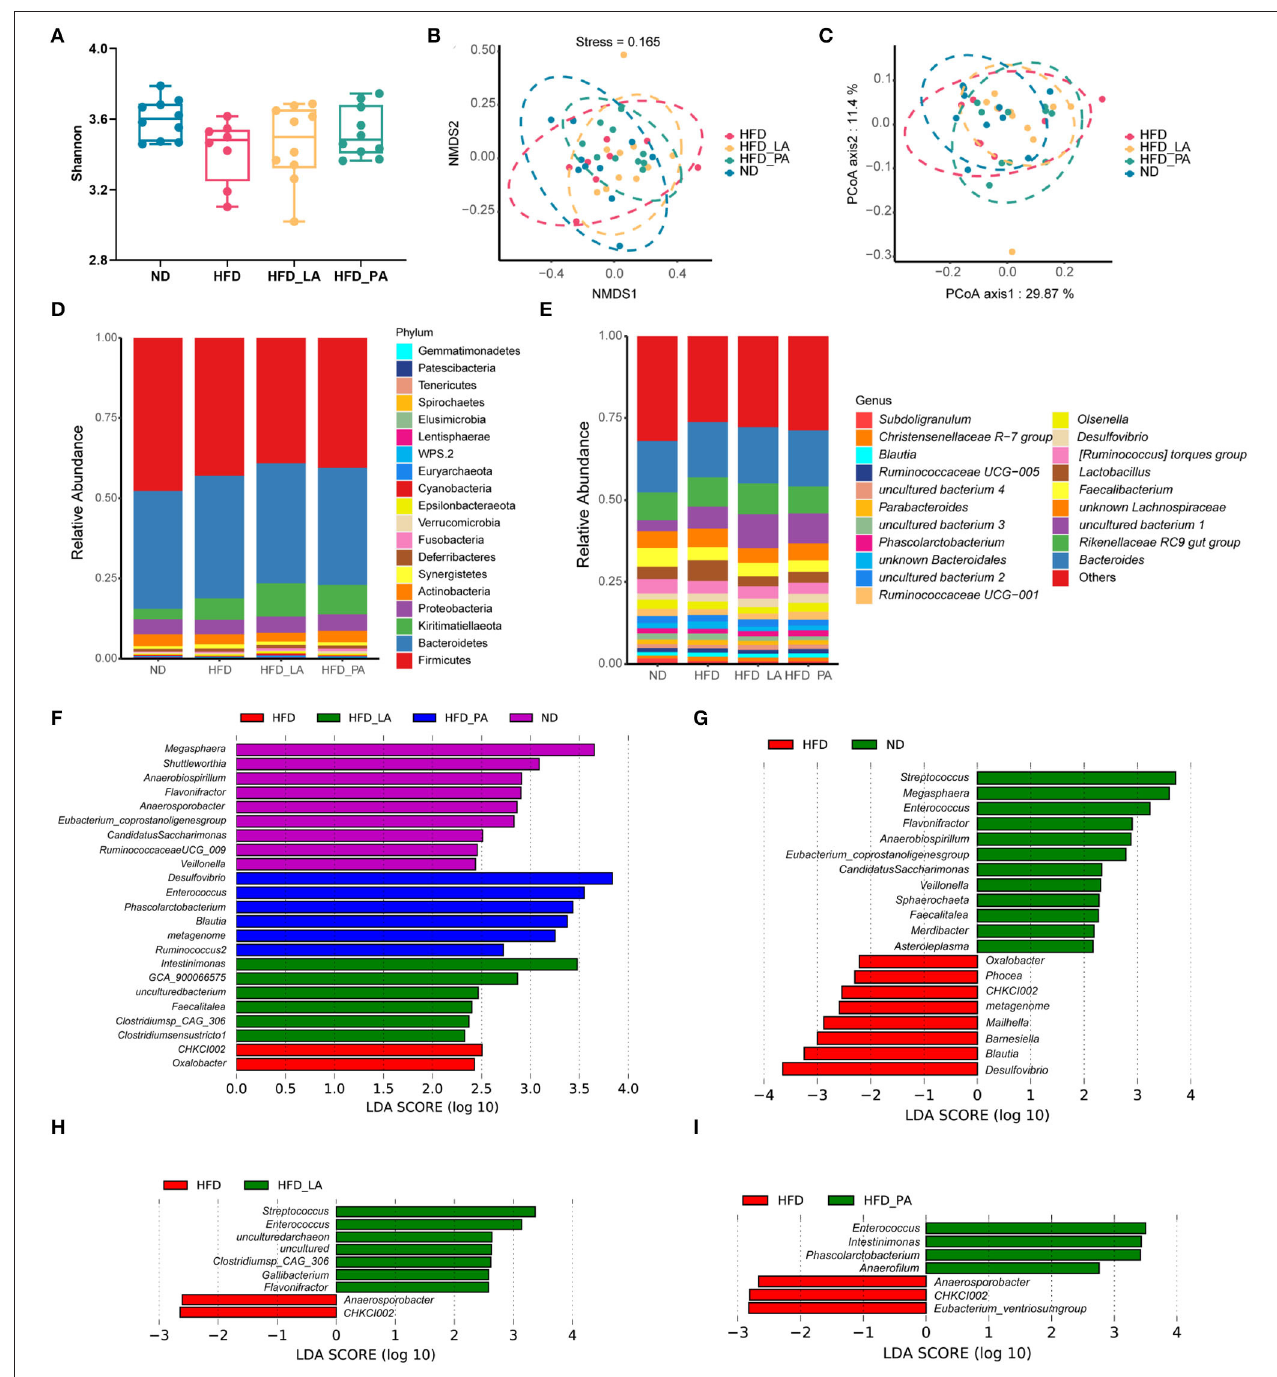
FIGURE 4 | Akkermansia muciniphila changed the composition of the gut microbiota in laying hens with fatty liver hemorrhagic syndrome (FLHS) ( n = 10). (A) Determination of gut microbiota diversity (as measured by the Shannon index). (B) Non-metric multidimensional scaling (NMDS) analysis. (C) Principal coordinates analysis (PCoA). (D) Taxonomic analysis of the gut microbiota at the phylum level. (E) Taxonomic analysis of the gut microbiota at the genus level. (F) The linear discriminant analysis (LDA) score shows a significant difference in bacterial composition among the four treatment groups. (G) The LDA score shows a significant difference in bacterial composition between high-fat diet (HFD)- and normal diet (ND)-fed laying hens. (H) The LDA score shows a significant difference in bacterial composition between HFD- and HFD + live A. muciniphila (HFD_LA)-fed laying hens. (I) The LDA score shows a significant difference in bacterial composition between HFD- and HFD + pasteurized A. muciniphila (HFD_PA)-fed laying hens. Different letters indicate significant differences at p < 0.05.